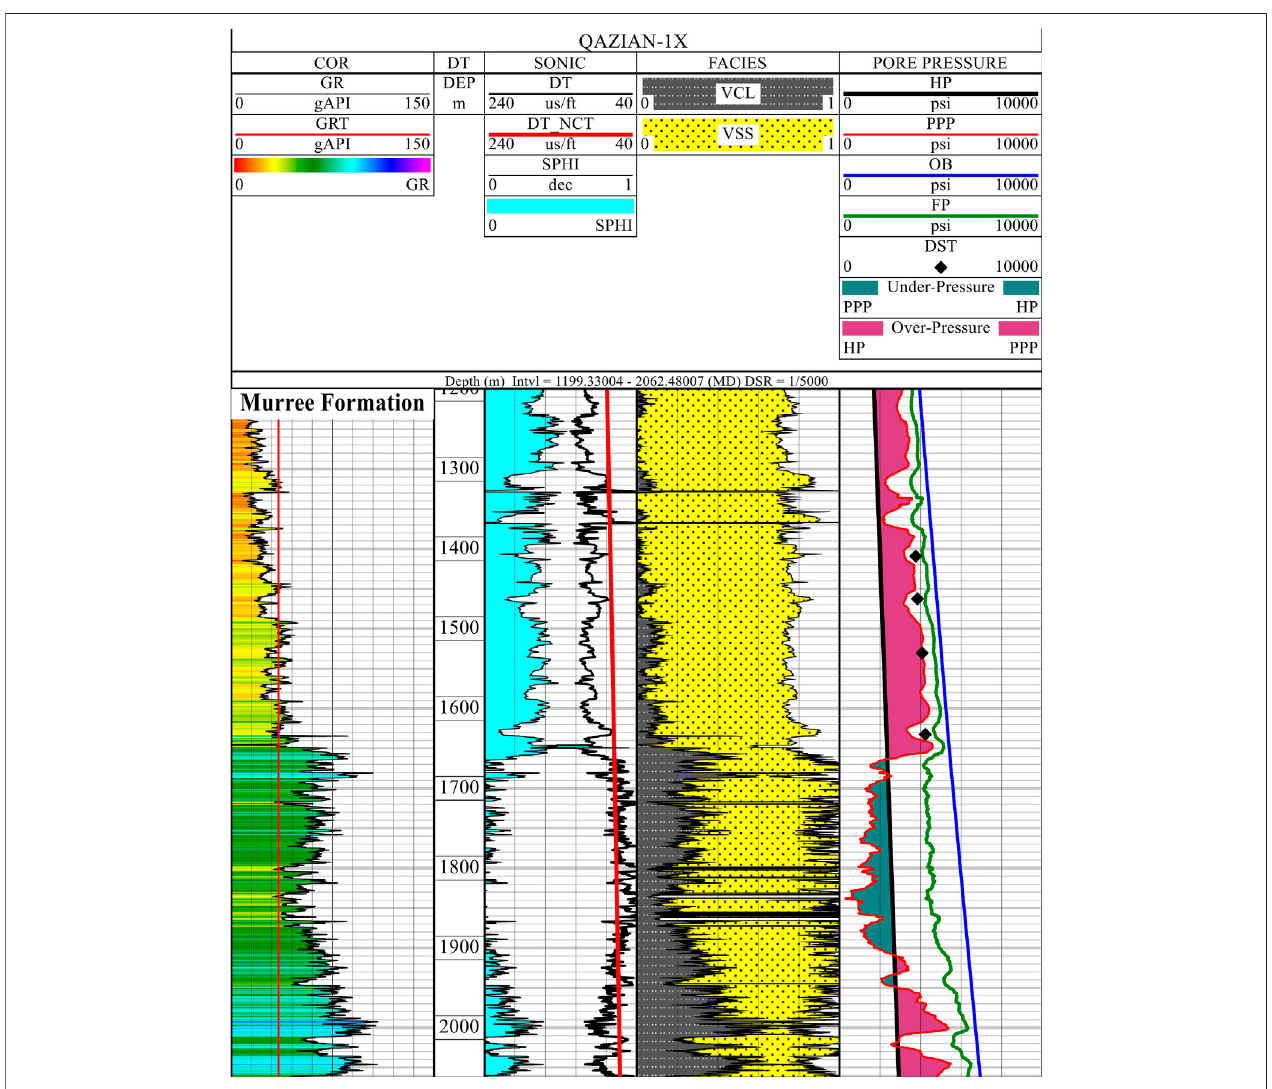
FIGURE 11 | Porosity, facies, and predicted pore pressure results of Murree Formation in Qazian-1X well along with calibrated DST data. Plotted data include the gamma ray curve in correlation track (COR); sonic logcurve, normal compaction trend line, and porosity in sonic track; predicted facies including clay and sand in facies track; hydrostatic pressure (HP) in black color, overburden pressure (OB) in blue color, predicted pore pressure (PPP) in red color, fracture pressure (FP) in green color, andDSTdata(blackdiamondsymbols)plottedinporepressuretrack.Cleansandfacieswithhighporositiesandoverpressurezonesareidenti fi edintopintervalof Murree Formation, showing a very good correlation with measured pressure values of DST data. Middle part of formation shows underpressure conditions with low porosityandhighpressuresinthelowermostpart.FPcurvedepictscrucialdrillingconditionsinupperpartasthePPPvaluesareveryclosetoFPcurve,whereasmiddle and lower part displays easier drilling